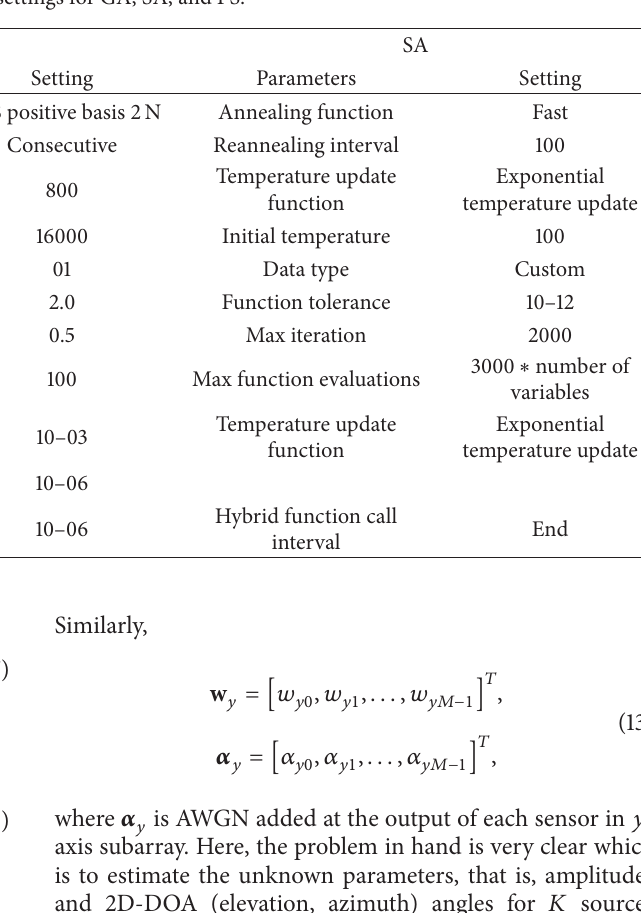
Table 1: Parameter settings for GA, SA, and